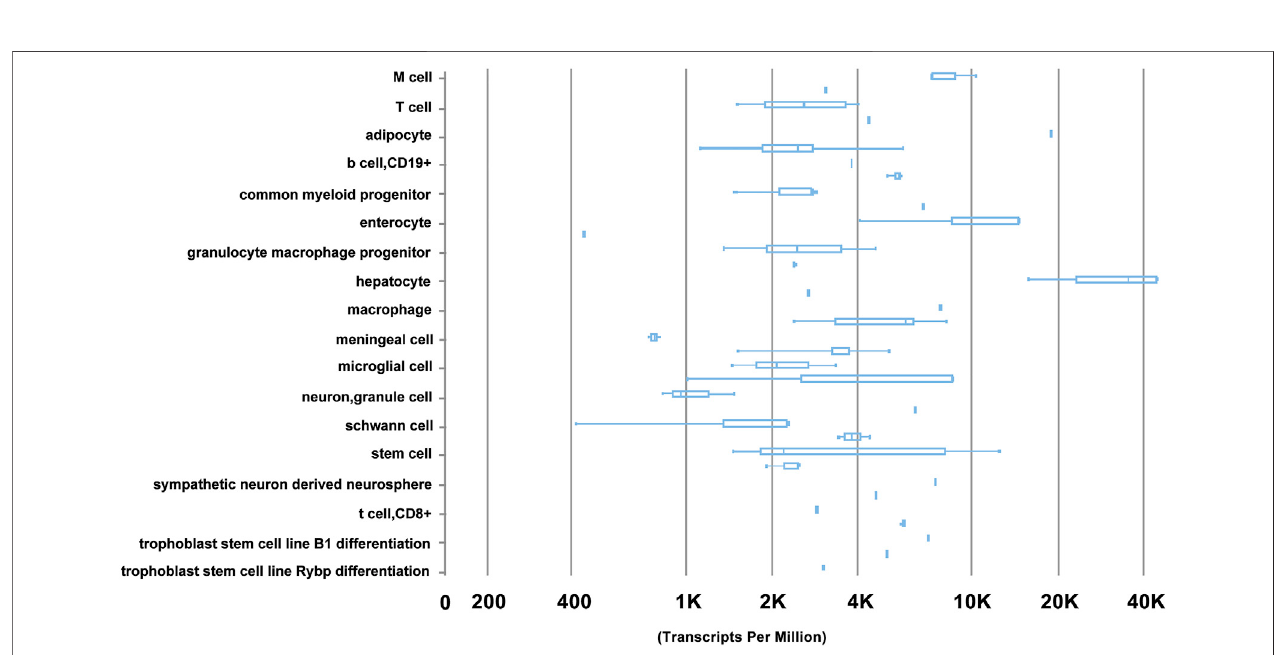
Frontiers in Cell and Developmental Biology |